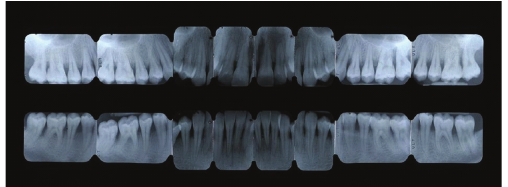
Figure 6: X-ray examination at baseline.